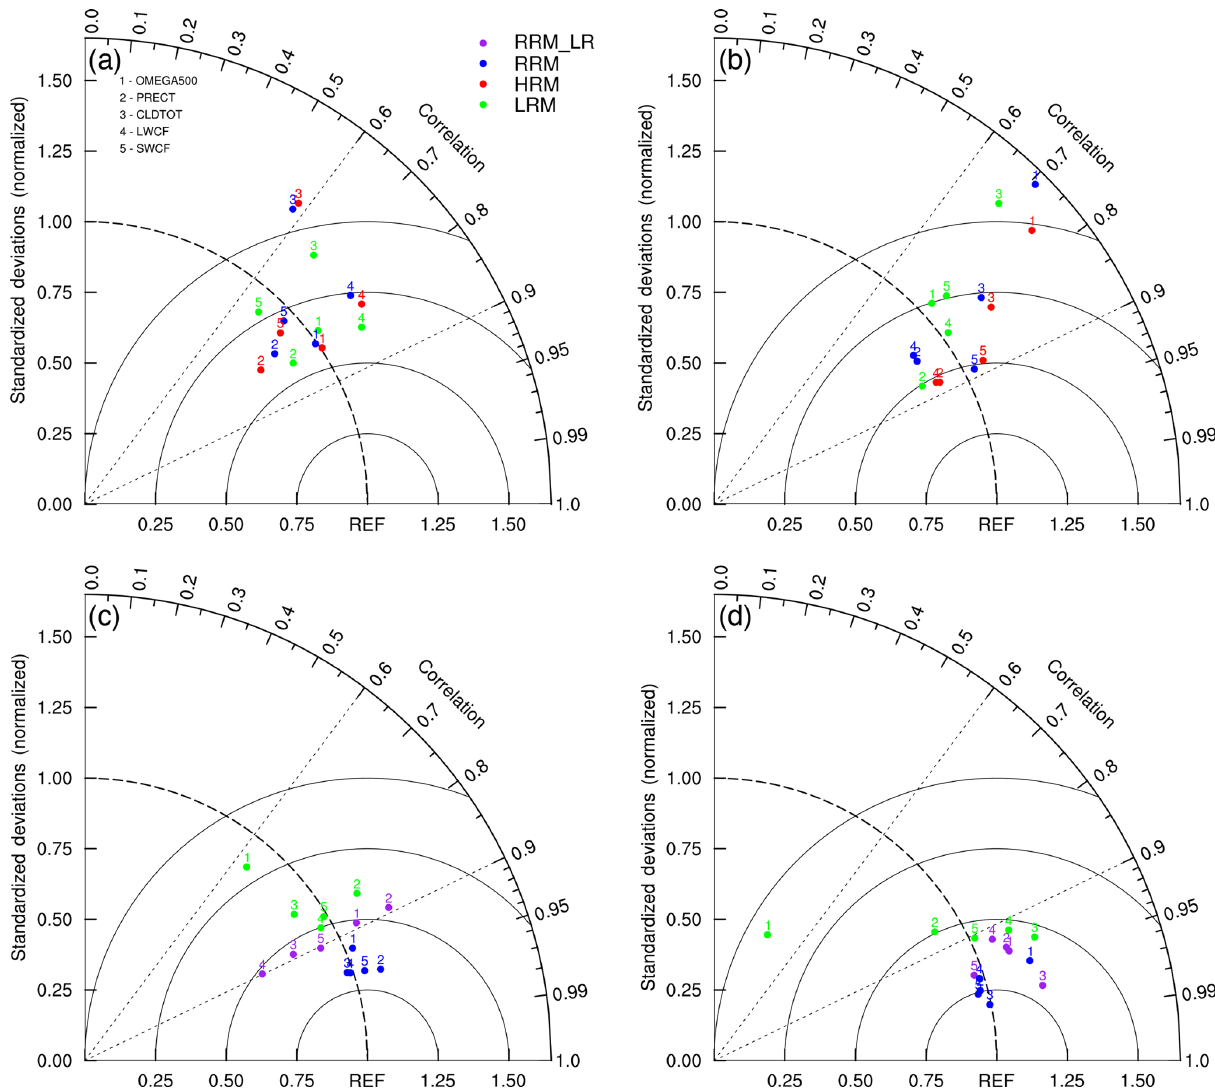
Figure 3. Same as Fig. 2, but the numbers represent the following: 1 – 500hPa vertical velocity (OMEGA500); 2 – total precipitation (PRECT); 3 – vertically integrated total cloud fraction (CLDTOT); 4 – longwave cloud forcing (LWCF); and 5 – shortwave cloud forcing